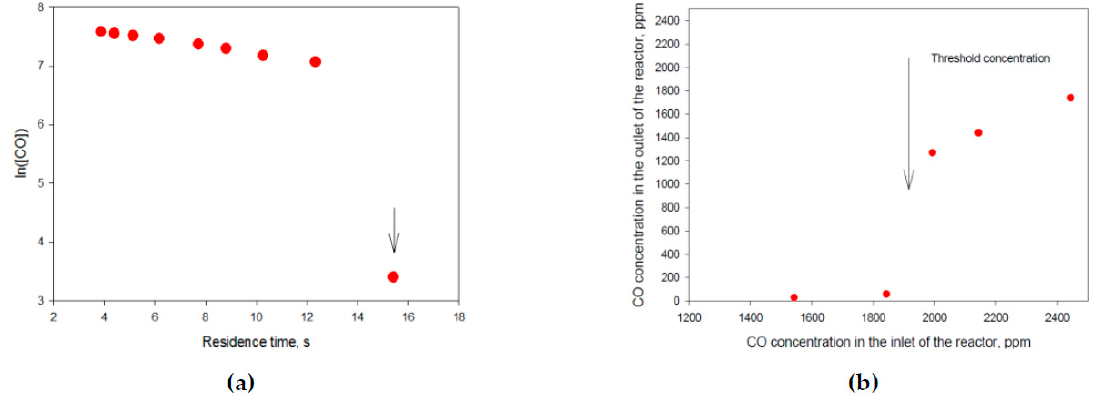
Figure 2. ( a ) First order kinetics of CO oxidation on catalyst 2 wt.% Pd on SnO 2 (55 m 2 /g). CO concentration on reactor inlet is 2310 ppm, O 2 concentration is 16% in N 2 , T = 108 °C. Measured is CO concentration in the reactor outlet; ( b ) CO oxidation on a catalysts 4 wt.% Pd on Al 2 O 3 (176 m 2 /g) O 2 concentration is 15% in N 2 , T = 106 °C. A decrease in inlet CO concentration bellows a threshold value leads to stepwise increase in reaction rate and to decrease in outlet